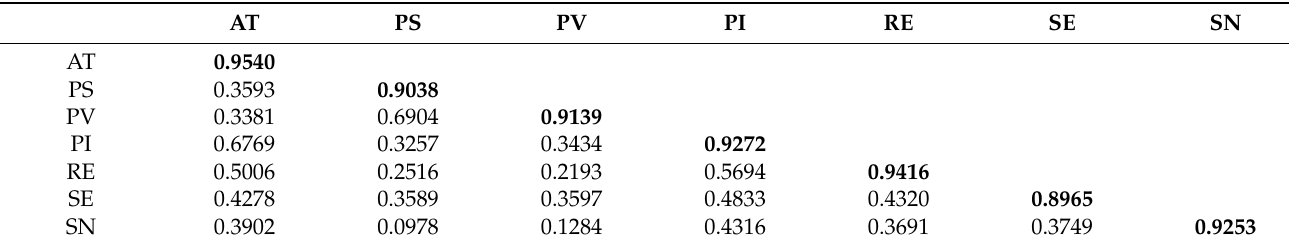
Table 5. Fornell–Larcker’s Criterion result.